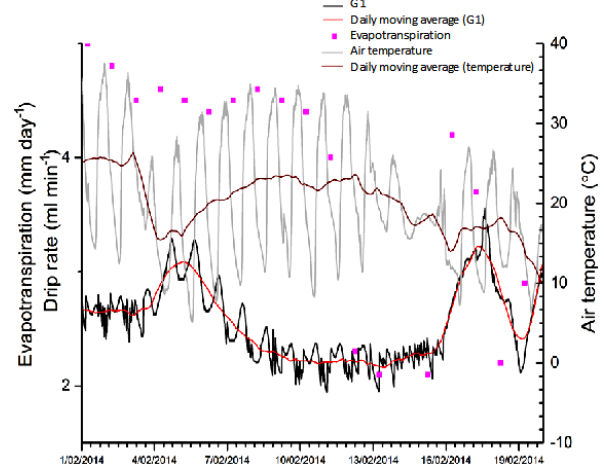
Figure 6. Surface air temperature, evapotranspiration and drip dis- charge rate with the corresponding daily moving average for site G1 1–19 February